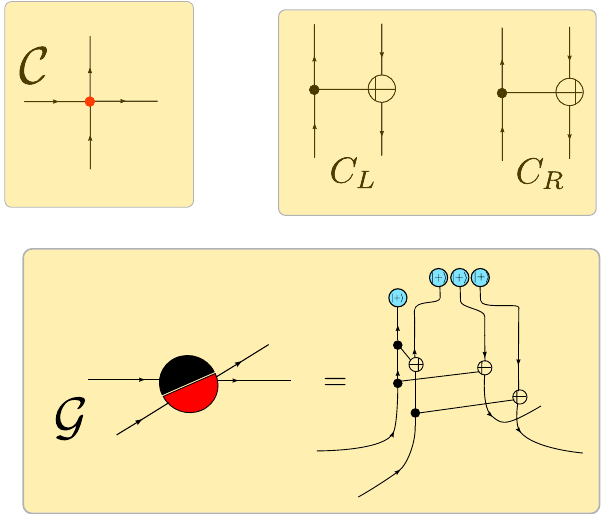
FIG. 11. The definition of the tensors C and G for the Kogut- Susskind LGT. The tensor G is obtained by composition of several copies of unitaries C They are followed by the projection onto the states jþi and defined in the main